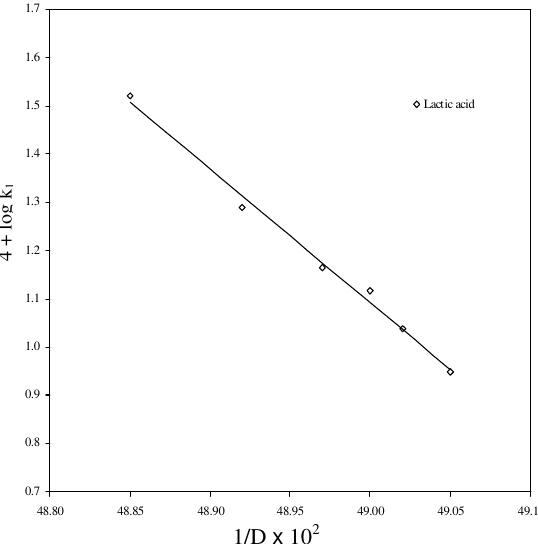
Figure 3. Variation of rate with solvent concentration (lactic acid)